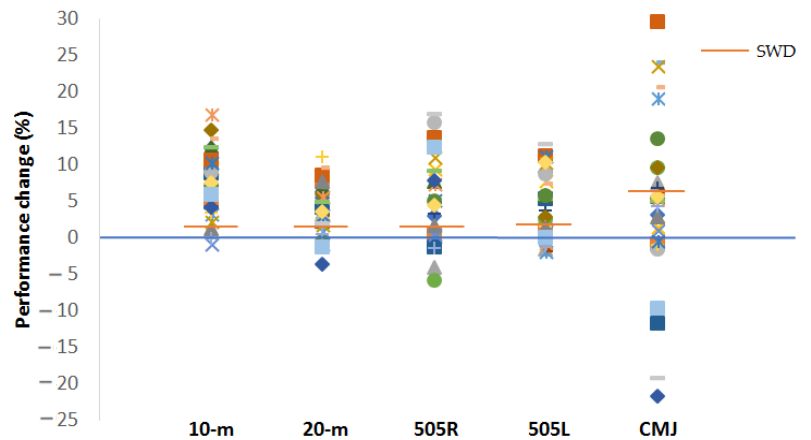
Figure 6. Individual percentage changes and smallest worthwhile changes for all five performance tests during the two testing points (TP1 and TP2). Each symbol represents the percentage change for each participant whereas the orange line indicates the percentage of the smallest worthwhile change for each test. Note: 505R = change of direction test for turns of the right leg; 505L = change of direction test for turns of the right leg; SWD = smallest worthwhile change (0.2 × between-subject SD).